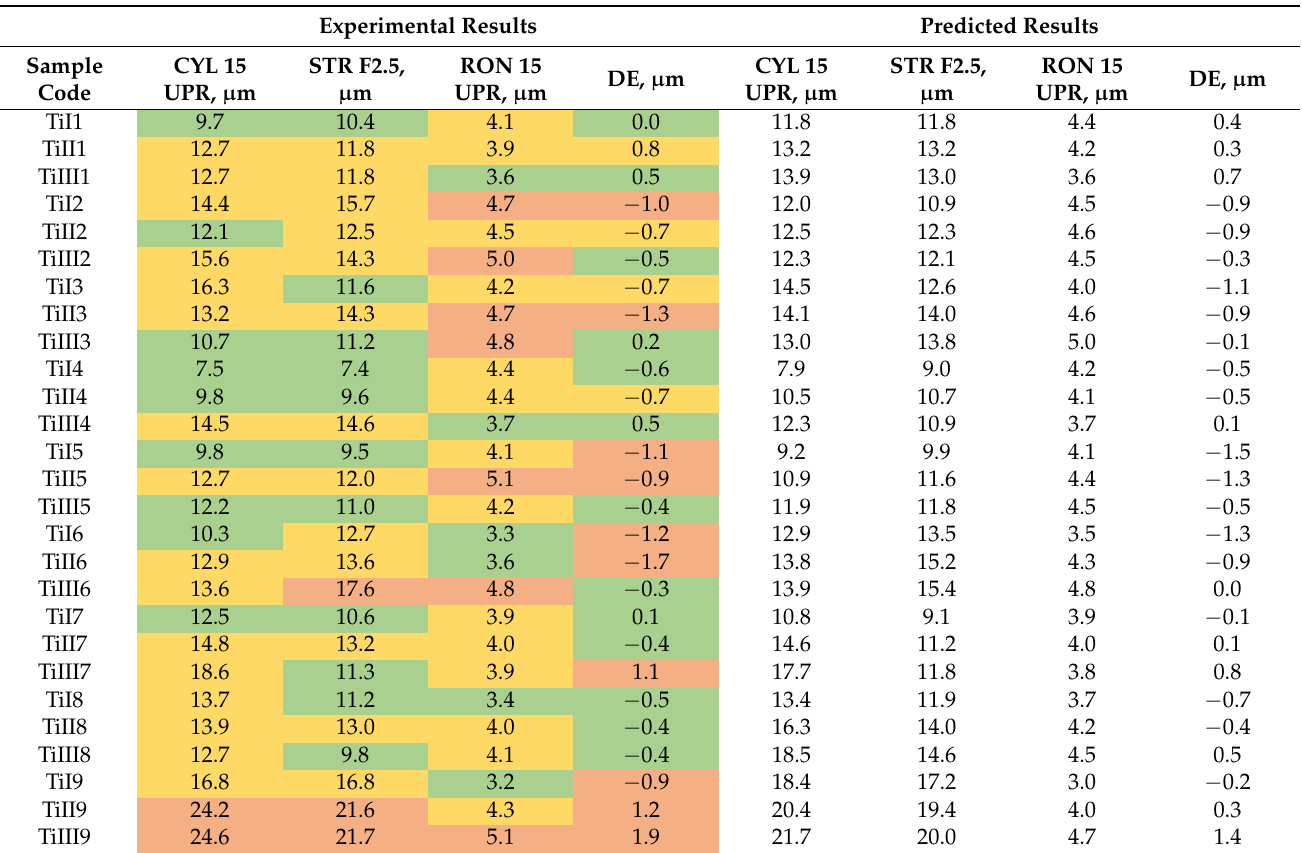
Table 5. Experimental vs. predicted values. Experimental Results Predicted Results